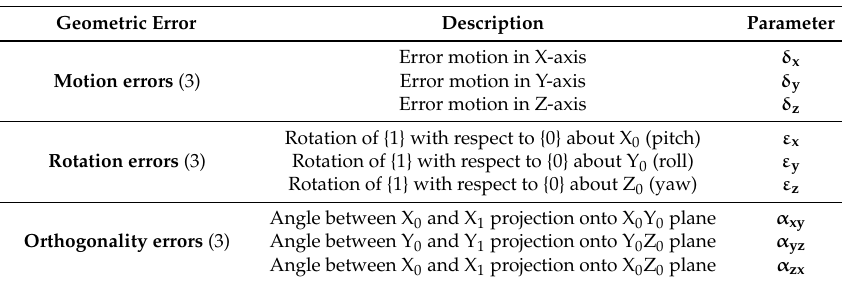
Table 2. Considered errors related to the {0}-{1}